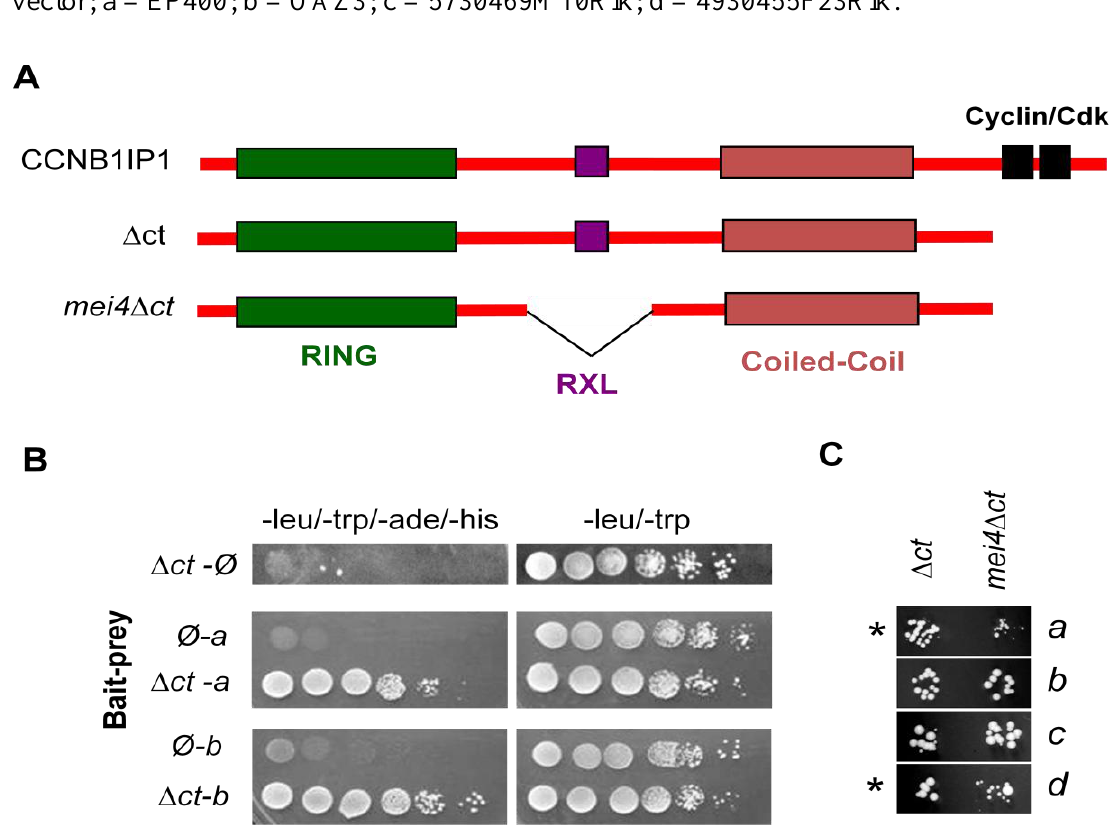
Figure 2. Yeast two-hybrid screen for CCNB1IP1 interacting proteins in the testis. ( A ) Structure of CCNB1IP1 and known motifs/domains. A C -terminal truncated construct was used as bait (∆ ct ). This lacks two potential phosphorylation sites of cyclin/cdk kinases. A bait construct with the deletion contained in the Ccnb1ip1 mei4 allele ( mei4 ∆ ct ) is shown at the bottom; ( B ) Confirmation of prey clones under maximal selection stringency (ade and his) with leu and trp selection for presence of bait and prey plasmids; ( C ) Growth of yeast containing 4 different prey and either the ∆ ct bait or the mei4∆ ct bait. A subset of CCNB1IP1 interactors (asterisks) were found to reproducibly display weaker interaction with mei4 ∆ ct than ∆ ct , as assessed by vigor of individual colony growth. Ø =